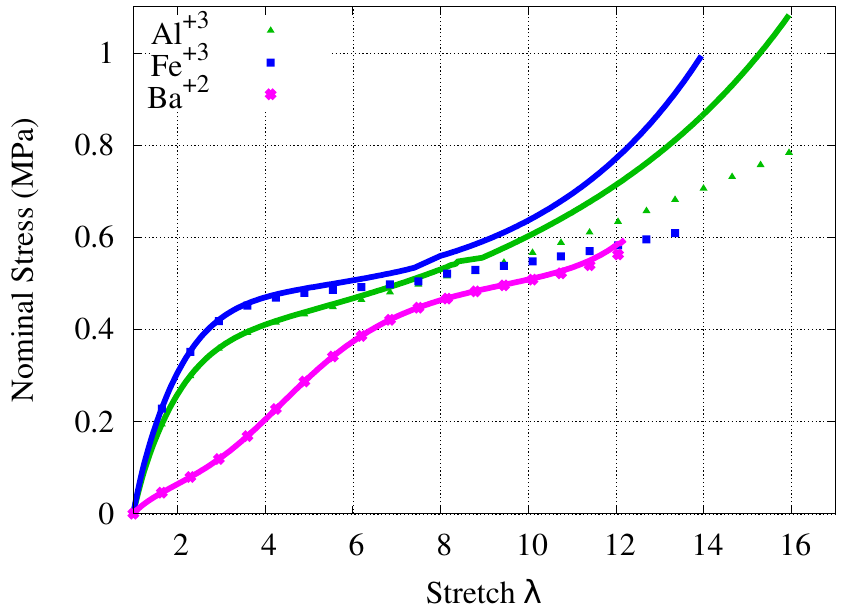
Figure 3. The effect of the enthapic part. (Lines: proposed model. Points: proposed model without enthalpic